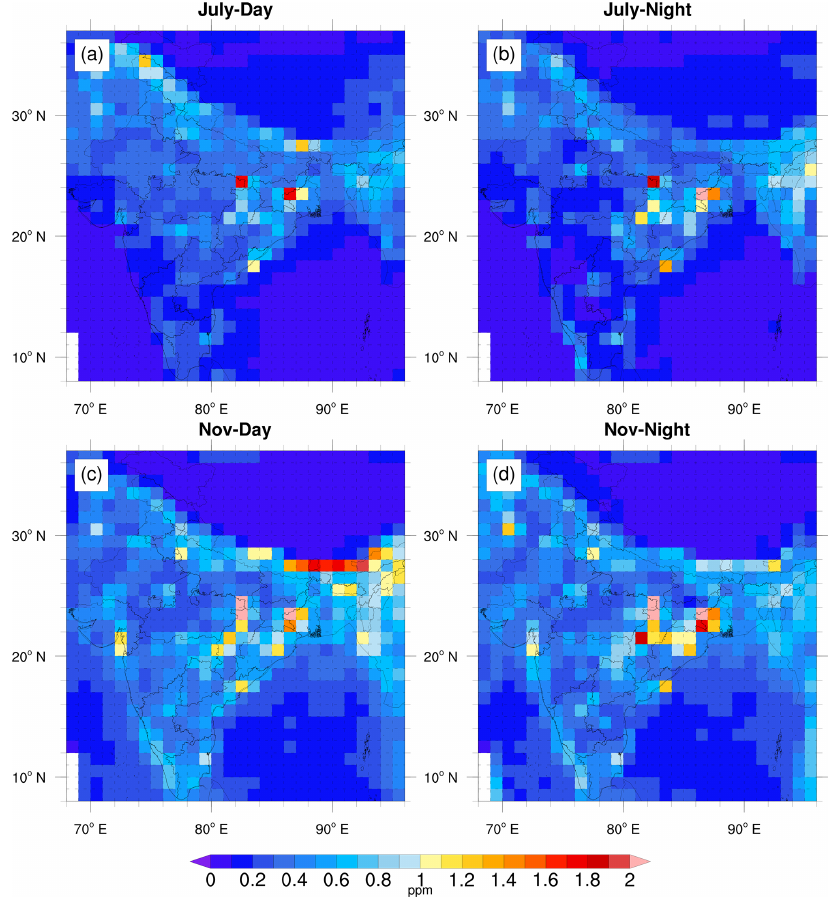
Figure 5. Monthly averaged values of representation error estimated for column-averaged CO 2 concentration over the region 8 to 37 ◦ N and 68 to 96 ◦ E during 2017. (a) July daytime (11:30 to 16:30LT). (b) July nighttime (23:30 to 04:30LT). (c) November daytime. (d) November